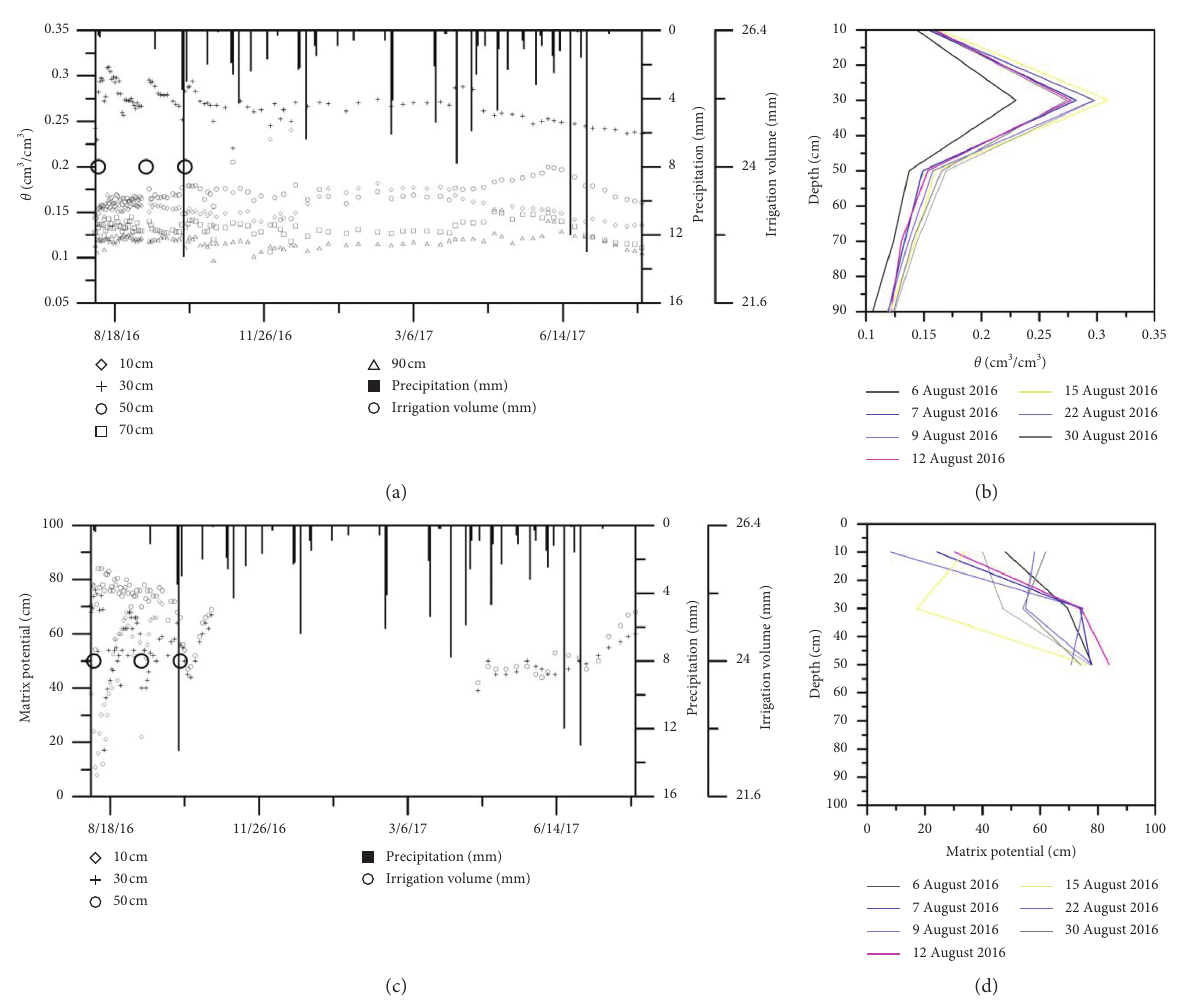
Figure 9: Water distribution in soil with a thickness of 50cm with compaction once: (a) water distribution at different depths; (b) response of water content to irrigation; (c) matrix potential at different depths; (d) response of matrix potential to